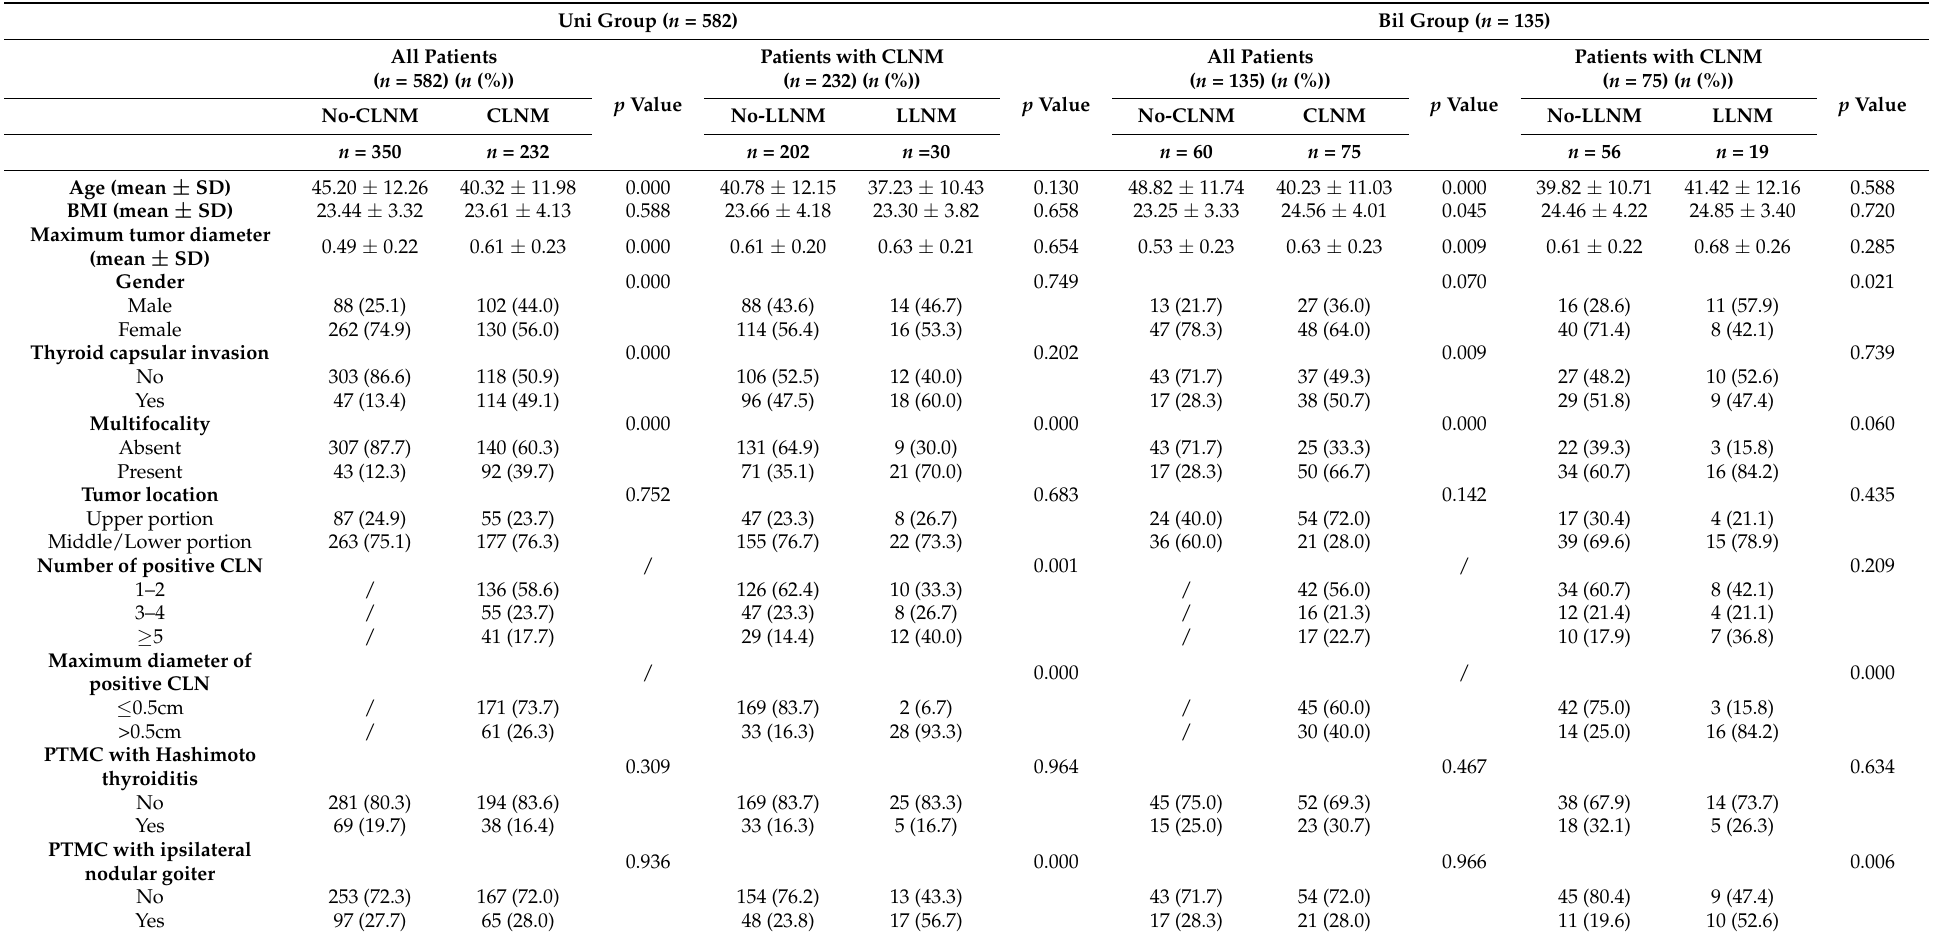
Table 2. The clinicopathological characteristics of PTMC patients with different lymph node metastasis status within Bil and Uni